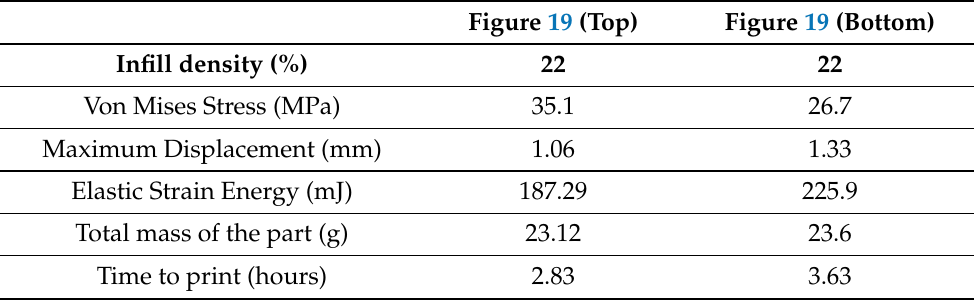
Figure 20. Printed parts with infill density of 22% having optimised infill design ( top ) and uniform infill design ( bottom ). Table 8. Comparison of the part with uniform infill to the part with infill defined by refinement process using threshold stress = 25 MPa and minimum length of a side of the infill design (L) ≥ 2.4 mm as stopping